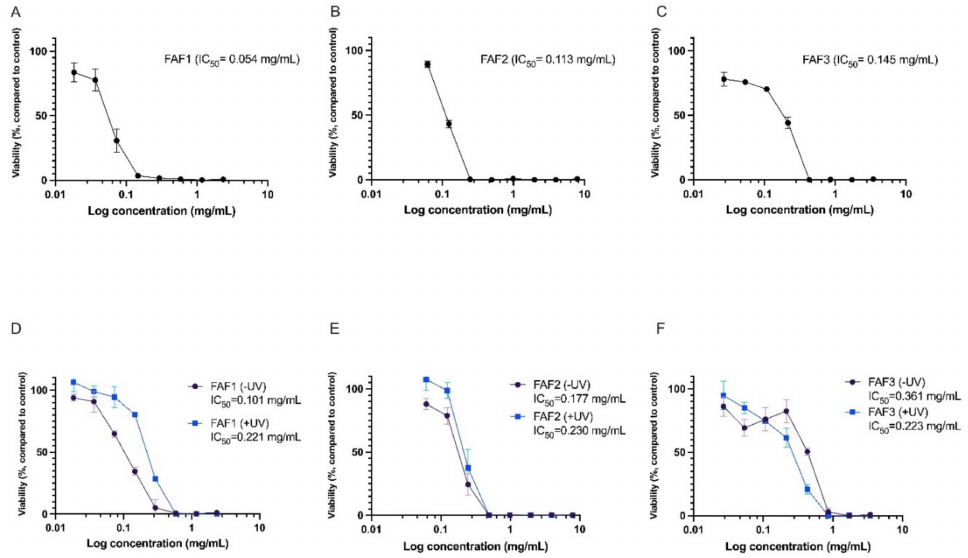
Figure 5. Cytotoxicity ( A – C ) and phototoxicity ( D – F ) assessment of Matricaria recutita white ray floret supercritical fluid extracts. -UV cells incubated with extracts for 1h without UV irradiation, +UV cells preincubated for 1h with extracts and irradiated with 5 J/cm 2 UVA; n =